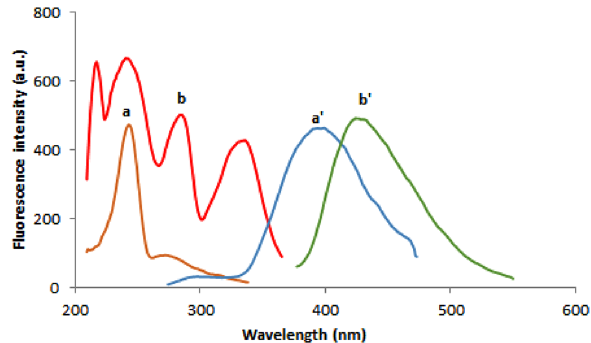
Figure 2. Excitation and emission spectra of 0.05 μg/mL REM (a, a ′ ) and 0.5 μg/mL SIM (b, b ′ ) in ethanol.